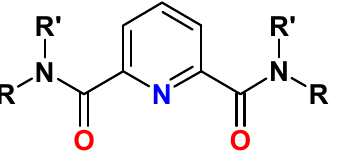
Figure 2. Diamides of 2,6-pyridine-dicarboxylic acid (DPA). Solutions of N,N′-dialkyl-N,N′-diaryldiamides of dipicolinic acid in polar solvents effectively extract actinides (III, IV, VI) [47,48] and lanthanides (III) from solutions with a nitric acid concentration of 1–6 M. With increasing acidity of the aqueous phase, the values of the distribution ratios of lanthanides increase to 6 M nitric acid [49,50].